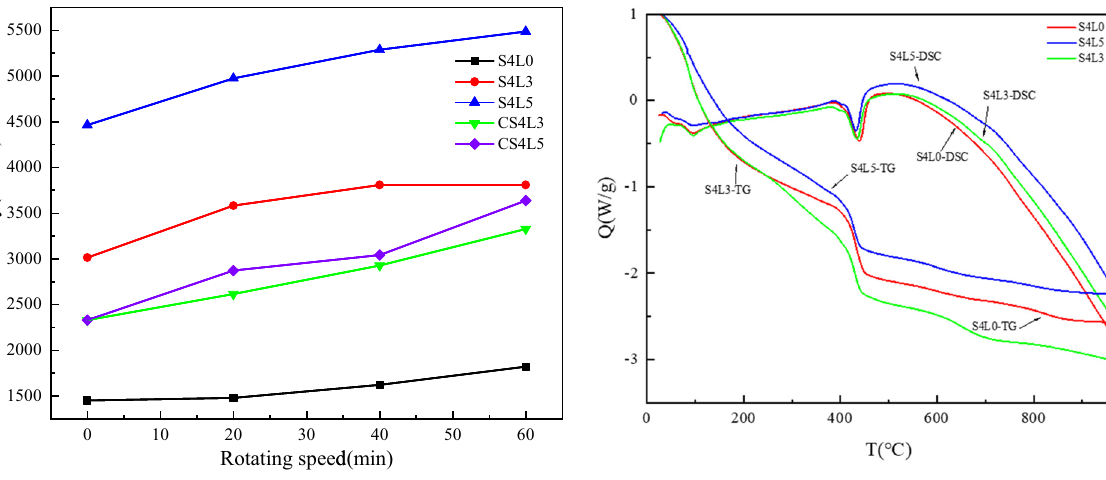
Figure 8: Experimental results of TG